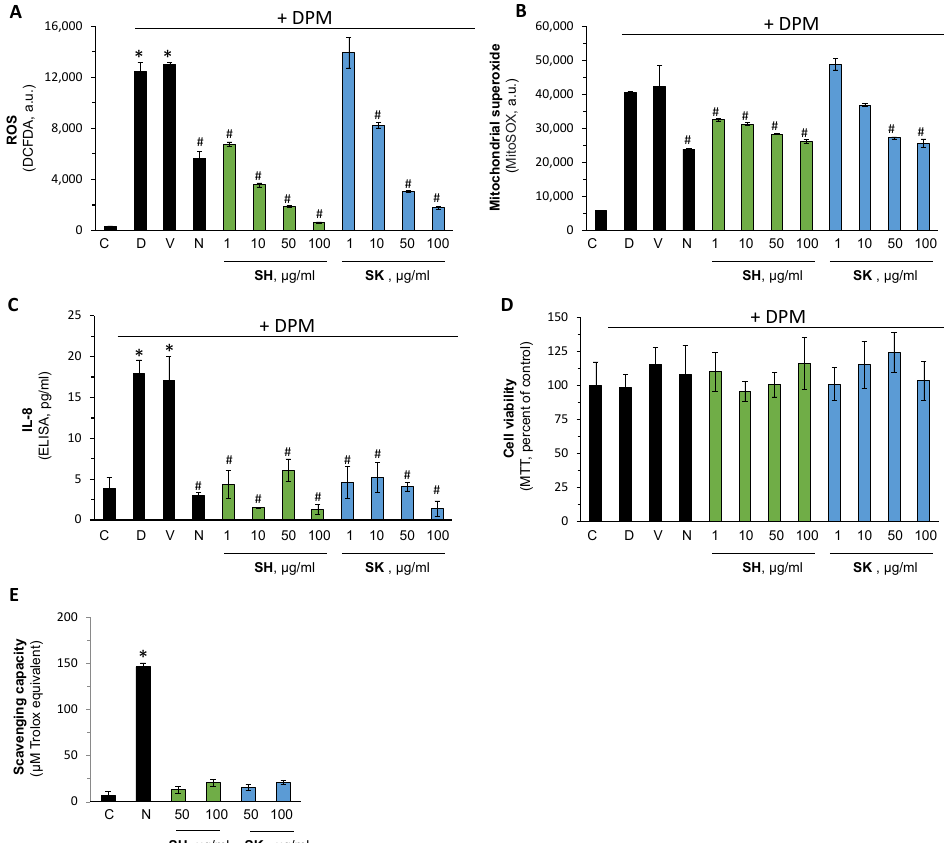
Figure 6. SH ‐ 29 and SK ‐ 119 attenuate DPM ‐ induced damage. HaCaT cells were treated w/o or with the indicated SH ‐ 29 or SK ‐ 119 concentration and exposed to DPM. After 45 min., cytosolic ( A ) or mitochondrial ( B ) ROS levels were measured by DC ‐ FDA or MitoSOX, respectively. After 24 h, IL ‐ 8 secretion ( C ) and cell viability ( D ) were determined by designated ELISA assay and MTT. In addition, the direct ROS scavenging capacity was evaluated by the DPPH method ( E ). n = 3; * /# p < 0.05 for signification different from naïve control cells or DPM ‐ stimulated group, respectively. C—control; D—DPM; V—vehicle, DMSO at 0.1%; N—N ‐ acetylcysteine; SH for SH ‐ 29 and SK for SK ‐ 119.